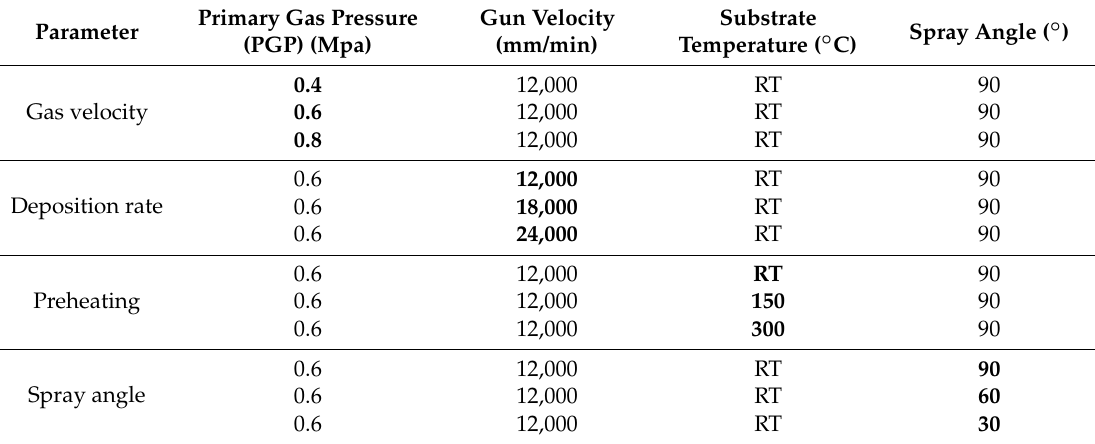
Table 1. Process parameter settings.